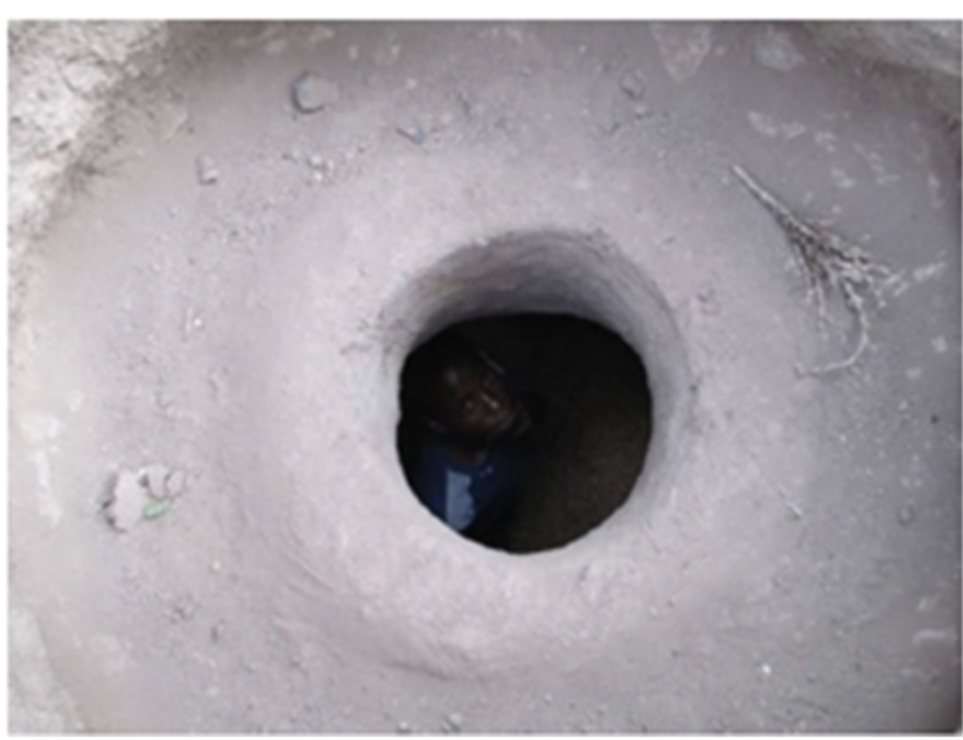
Figure 1. Large traditional underground pit for sorghum in Fedis, Ethiopia. Source; taken from FAO, 2017